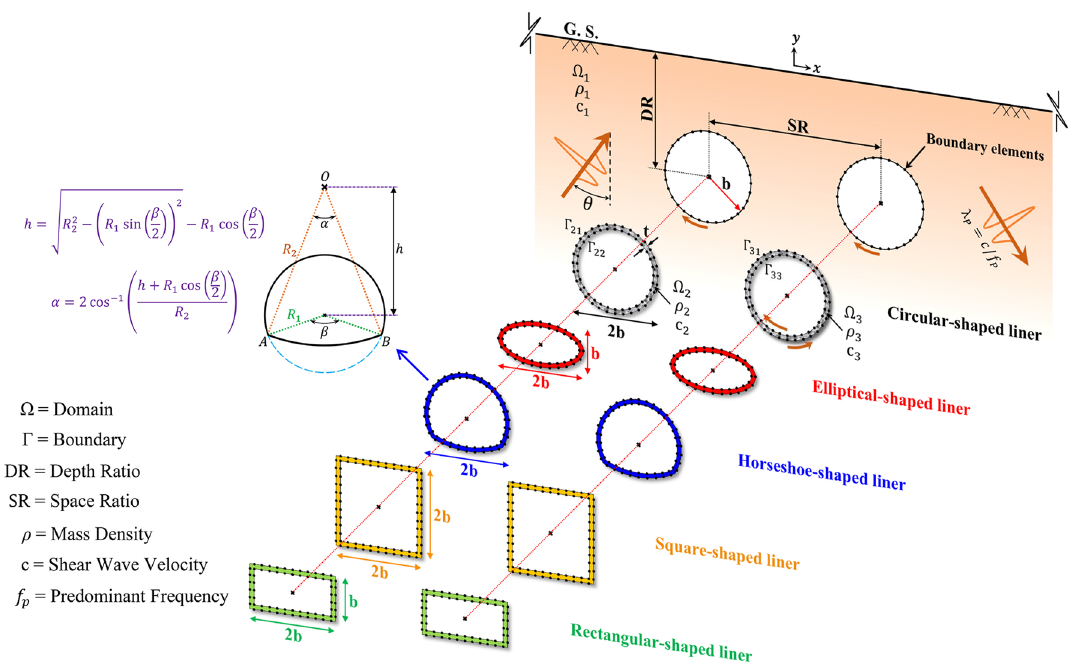
Fig. 1 The schematic HP-BEM model for the twin lined tunnels with different geometries subjected to the incident SH